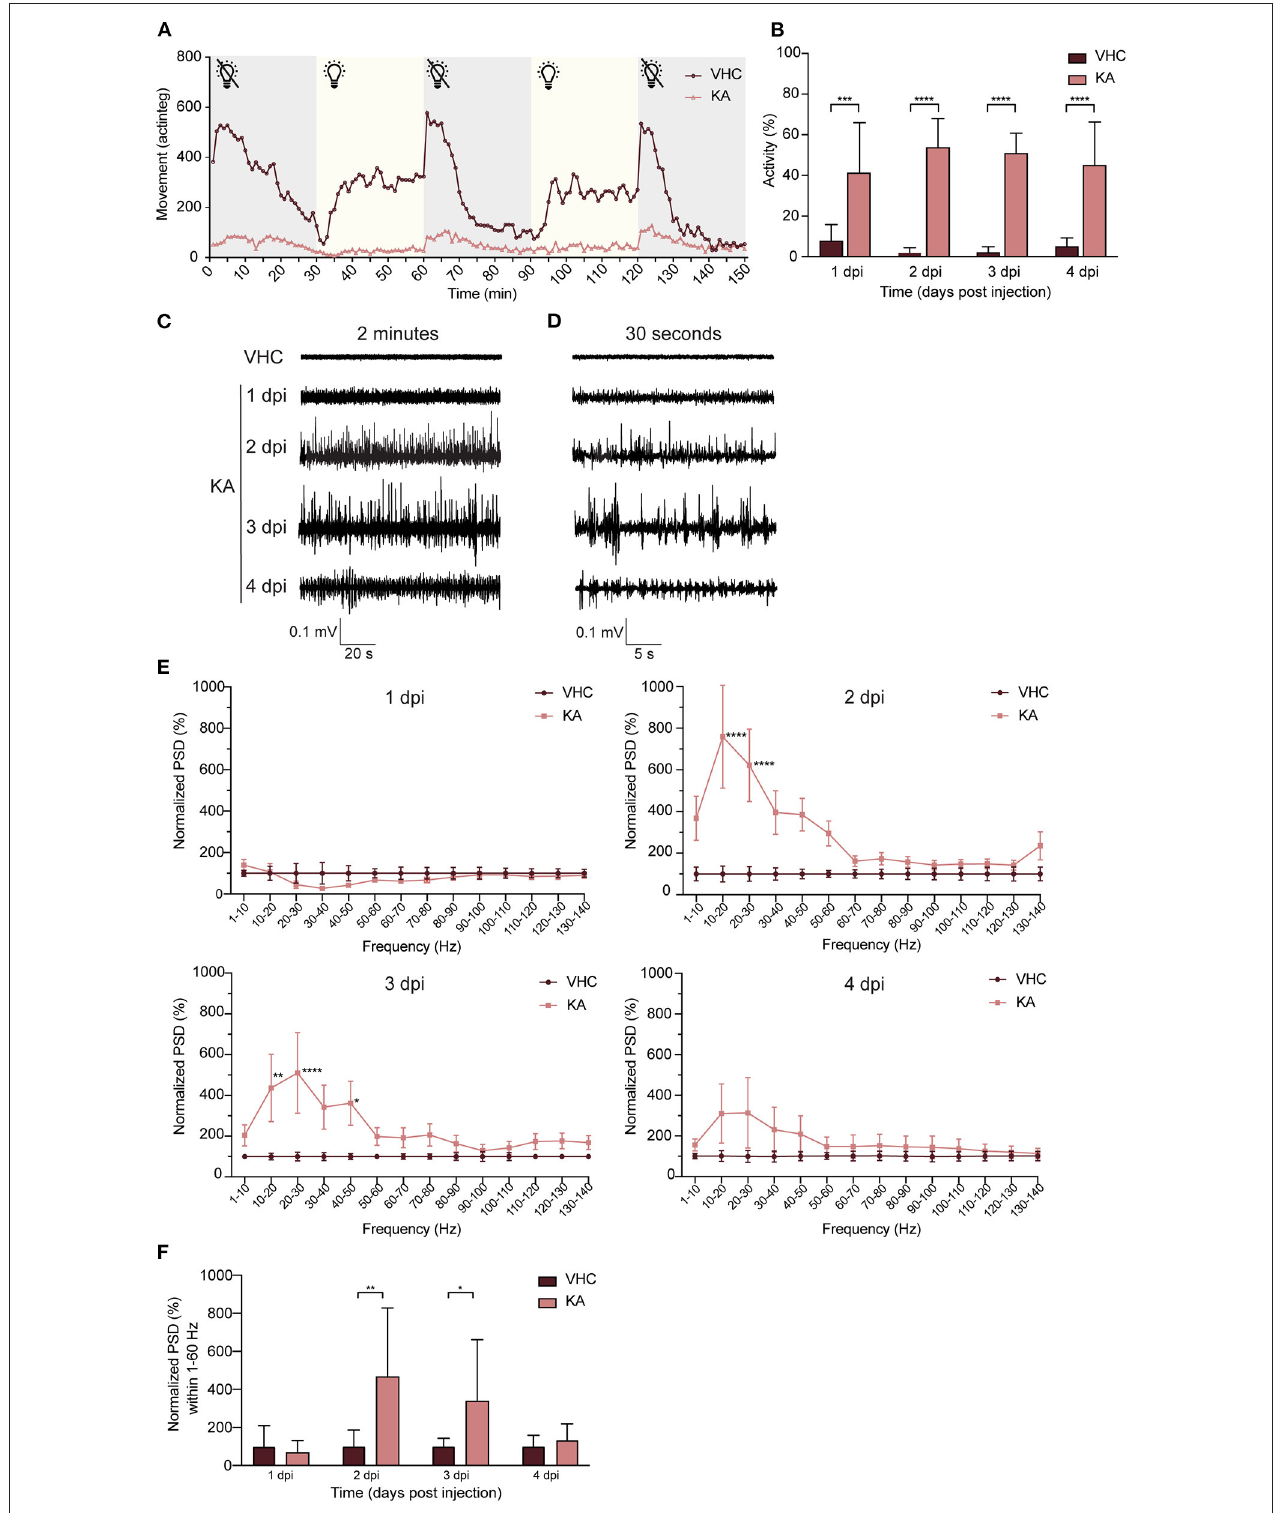
FIGURE 4 | Kainic acid injected larvae display seizure-like behavior and continuous epileptiform discharges as measured by non-invasive local field potential recordings. (A) Decreased locomotor activity of KA-injected larvae at 3 dpi ( n = 25) during interchanged dark and light periods of 30min during 150min in comparison to VHC-injected controls ( n = 18). Error bars were not displayed for the sake of clarity. (B) Analysis of seizure-like behavior of KA-injected larvae at 1–4 dpi in